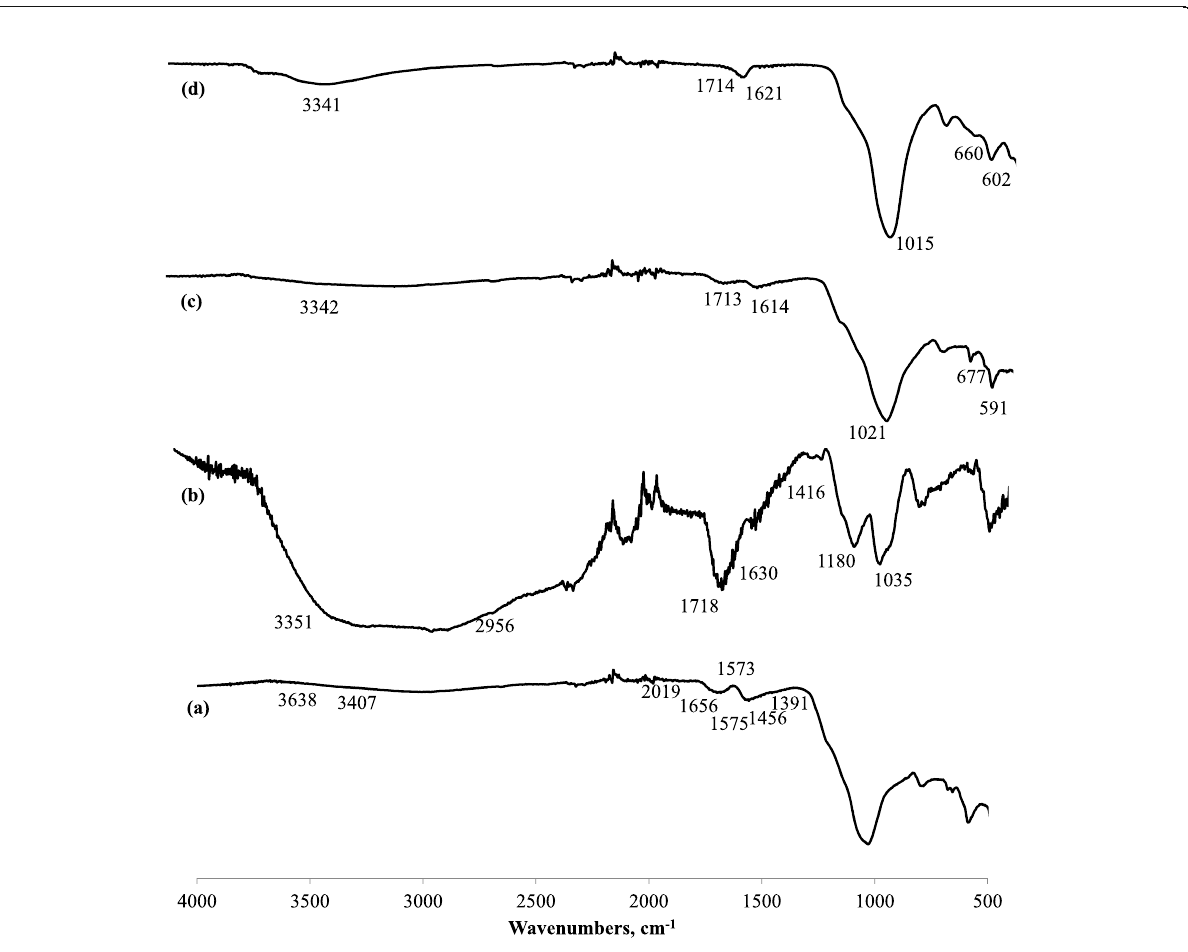
Fig. 3 FTIR absorption spectra of a FeZ, b GO, c GOFeZA, and d